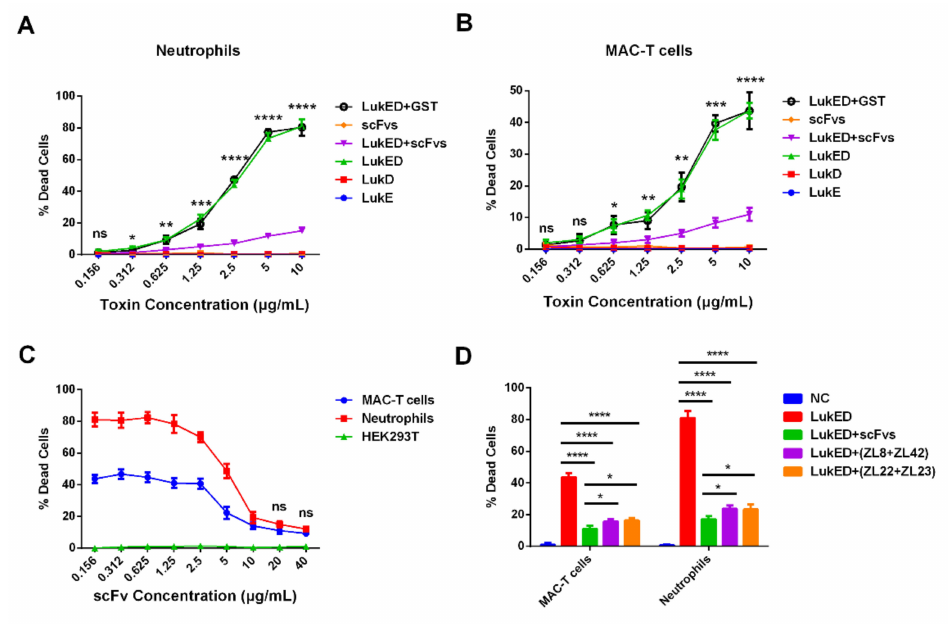
Figure 4. The function of scFvs is to inhibit LukED-mediated cell killing. ( A , B ) The cell killing of bovine neutrophils and MAC-T cells upon incubation with the scFvs mixture and different concen- trations of LukED, respectively. ( C ) The protective effect of different concentrations of scFvs on the inhibition of LukED-mediated cell killing. ( D ) The protective effect of different groups of scFvs (ZL8 + ZL42 group, ZL22+ZL23 group and the scFvs mixture group) on the inhibition of LukED- mediated cell killing. * p , ** p , *** p , **** p vs. LukED group. Data represent the mean results ± SD (n = 3) (ns = p > 0.05, * p < 0.05, ** p < 0.01, *** p < 0.001, **** p < 0.0001). Data represent the mean results ± SD (n =